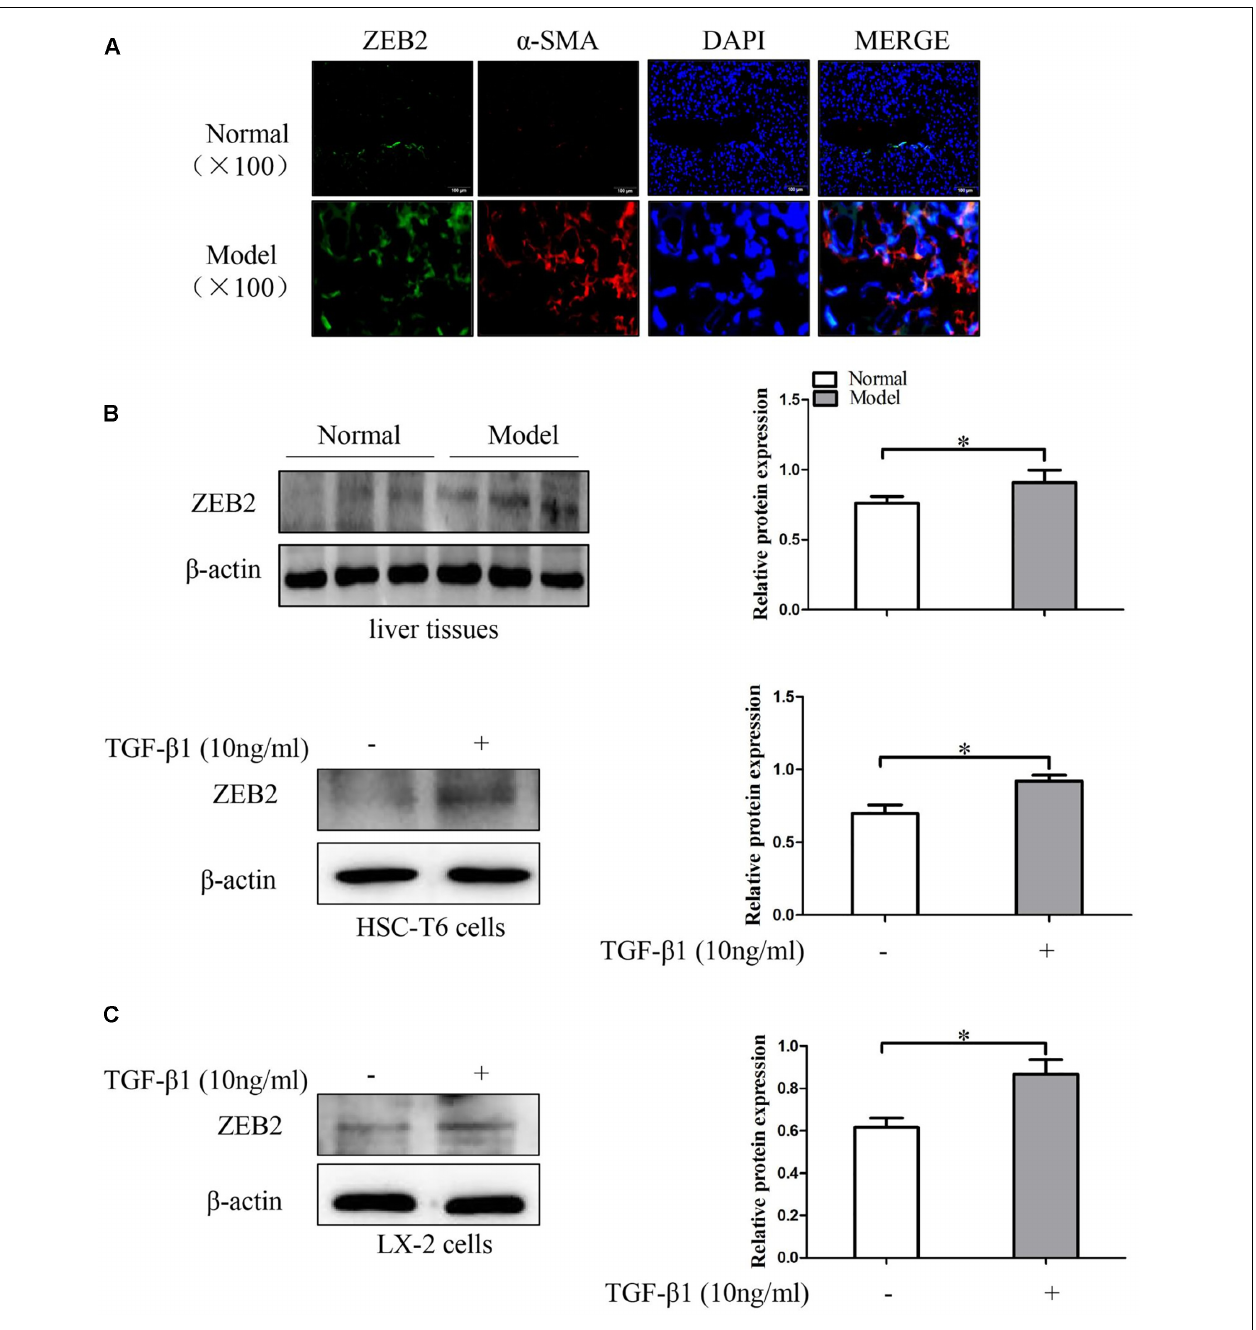
FIGURE 5 | The expression of ZEB2 in mice liver fibrosis tissues and TGF- β 1-treated HSCs. (A) Immunofluorescence staining with ZEB2 and α -SMA were performed to detect the co-localization of ZEB2 (red) and α -SMA (green) in liver fibrosis tissues. Representative images of Immunofluorescence staining are presented ( × 100). (B) The level of ZEB2 was evaluated by Western blot analysis in liver fibrosis tissues. (C) HSC-T6 cells and LX-2 cells were treated with TGF- β 1 (10 ng/ml) for 24 h, and then protein expression of ZEB2 were determine by Western blot analysis. The assays were performed at least three times with similar results. Data are shown as the mean ± SD ( n = 3) of one representative experiment. ∗ p < 0.05 versus normal